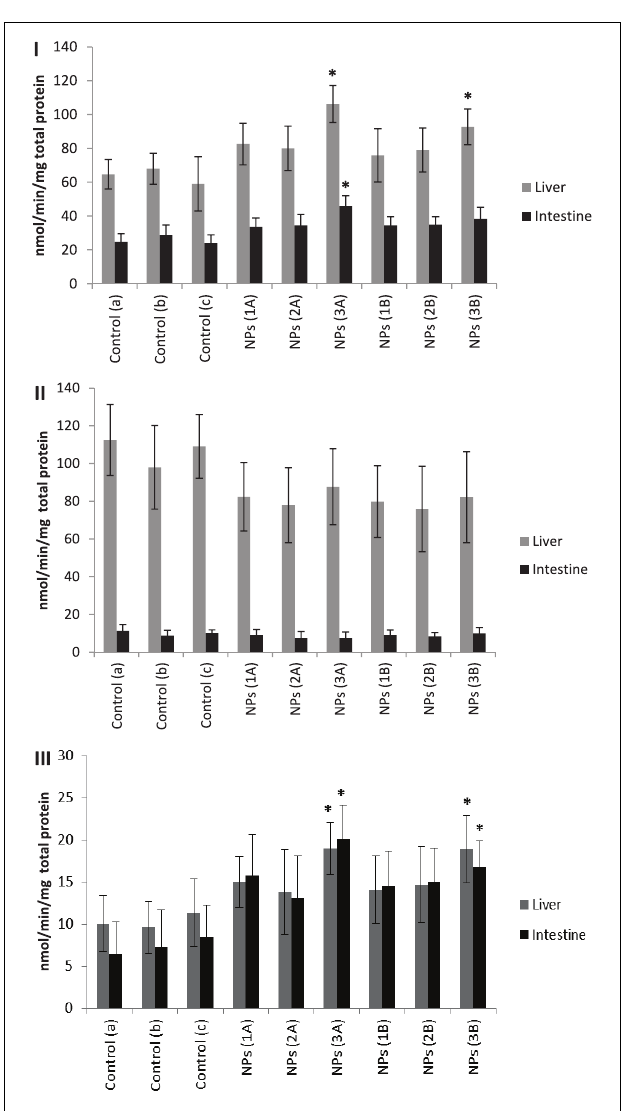
FIGURE 3 | (I) GST, (II) CAT, and (III) MDA concentrations in the liver and intestine tissues of Carassius auratus treated with AgNPs for 48h. Data are presented as means ± SD. The asterisks indicate significant differences ( p < 0 . 05) in comparison to controls. A—Intraperitoneal injection of AgNPs in PBS (1:10); B—Intraperitoneal injection of AgNPs diluted in corn oil (1:10). Legend: control (a) PBS (phosphate buffer solution), control (b) a solution of PBS and THF (1:10); and control (c) a solution of PBS and corn oil